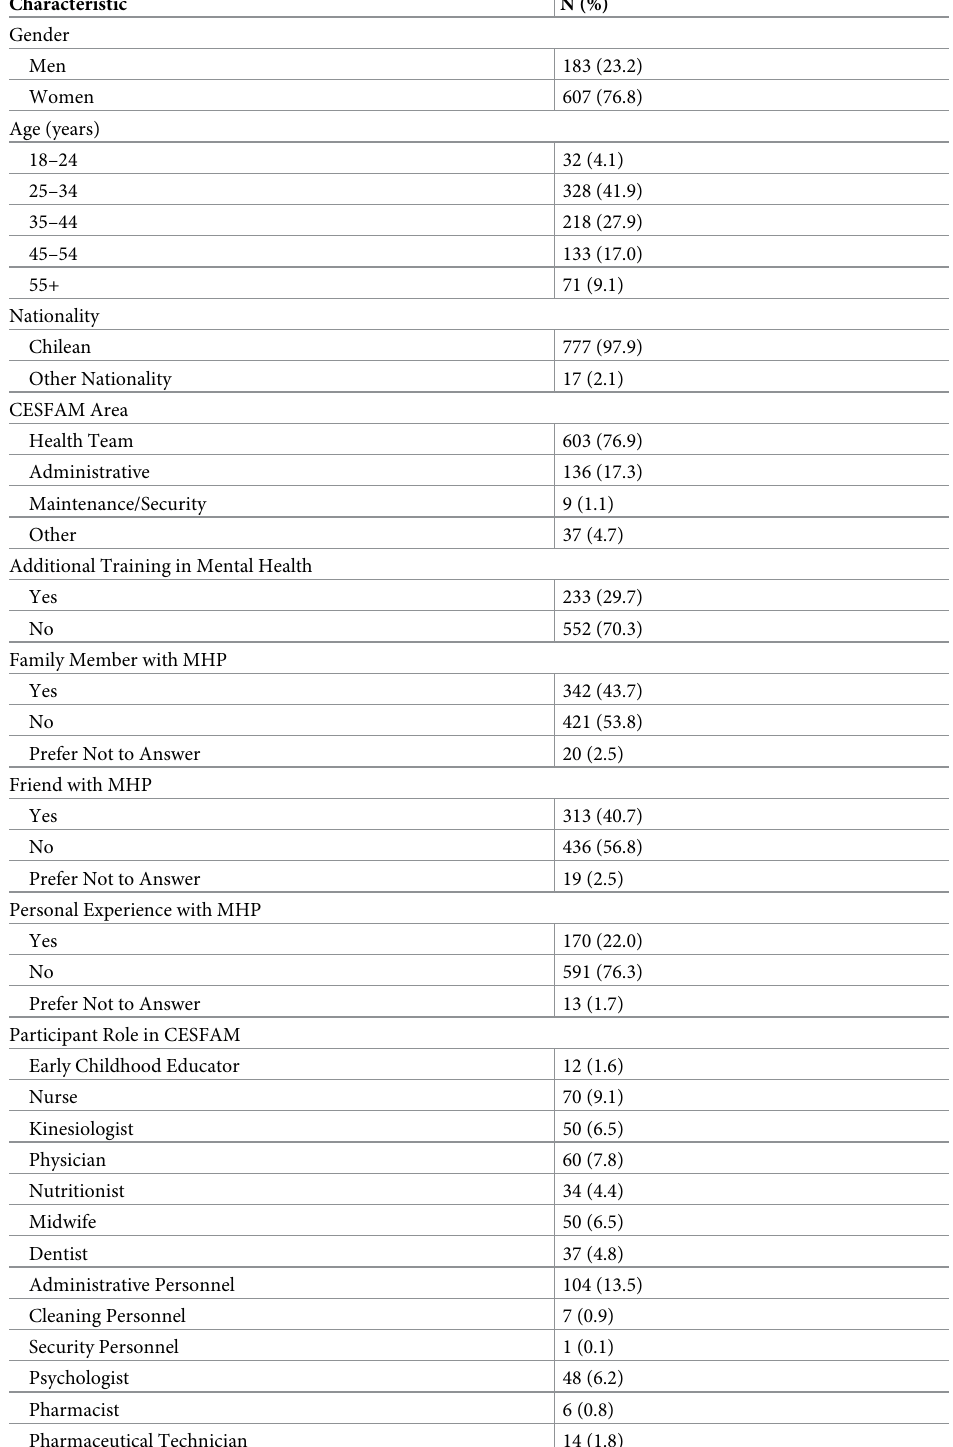
Table 1. Sociodemographic characteristics of sample of Chilean primary health care staff and providers (N =